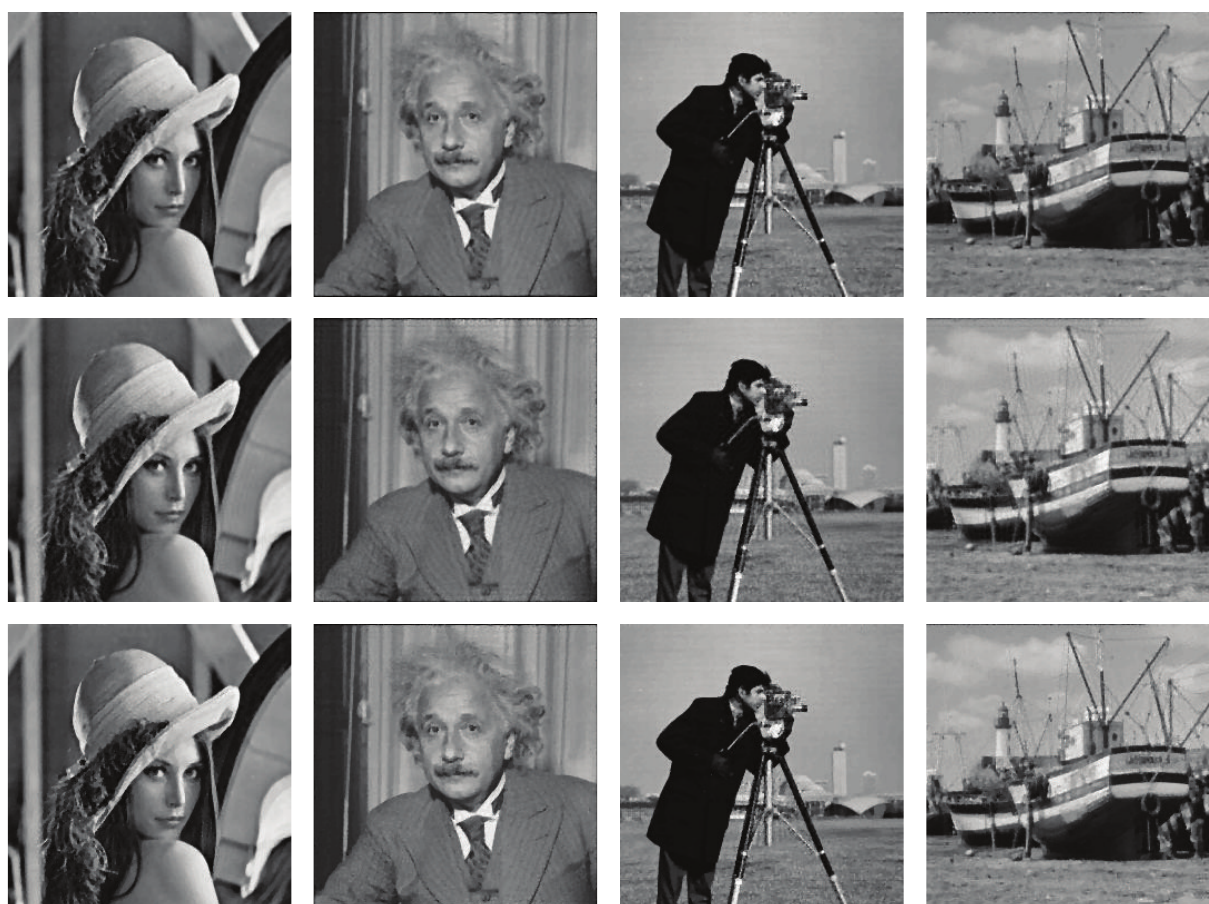
Figure 2: Images blurred with out-of-focus kernel of radius 3 and then corrupted by salt-and-pepper noise with noise level 𝑠 = 7 0%. Top: the restored images by MNID-ADMM and the parameters we used are [ 𝛼 1 = 0.01 , 𝛼 2 = 0.005 , 𝛽 1 = 𝛽 2 = 0.01 , 𝛽 3 = 5𝑒 − 6 ]. Middle: the restored images by Cai-TP. Bottom: the restored images by